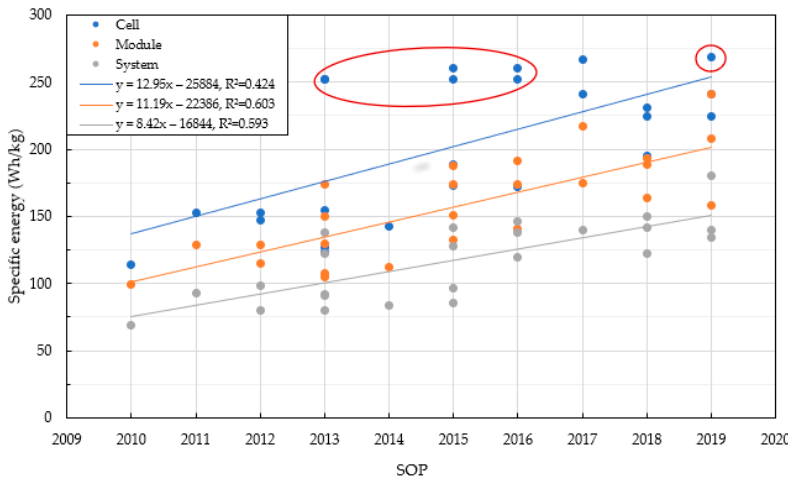
Figure 2. Development of the specific energy (Wh/kg) in the years between 2010 and 2019. Blue represents the development on cell level, orange represents the module level, and grey represents the system level.